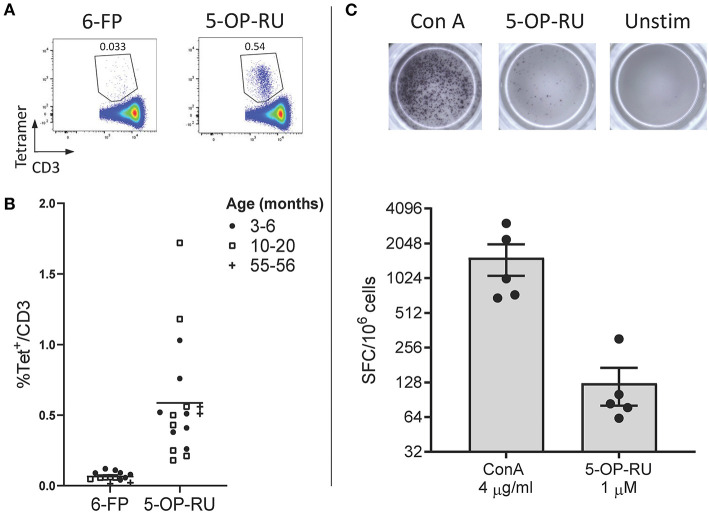
Identification of MAIT cells in cattle. (A) Representative flow cytometry plots depicting human MR1-6-FP and MR1-5-OP-RU tetramer staining of bovine PBMC, gated on CD3+ cells. (B) Fraction of human MR1-5-OP-RU (mean 0.59, range 0.18–1.72, n = 17) and MR1-6-FP (mean 0.06, range 0.01–0.12, n = 14) tetramer+ cells within MHC-II− CD3+ PBMCS from cows of various ages. (C) Representative images and summarized data (mean ± SEM, n = 5) of IFN-γ secreting cells following stimulation of PBMC with 5-OP-RU and Concanavalin A (ConA) as a control. Responses are medium control subtracted.